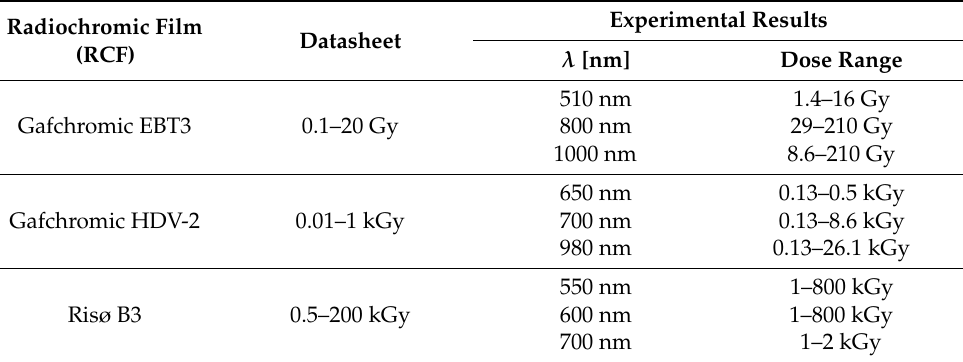
Table 1. Comparison of the dynamic range, declared by the manufacturer, to the experimental one, defined in this study for EBT3 gafchromic films, HDV-2 gafchromic films, and Risø B3 films. λ denotes the wavelength.